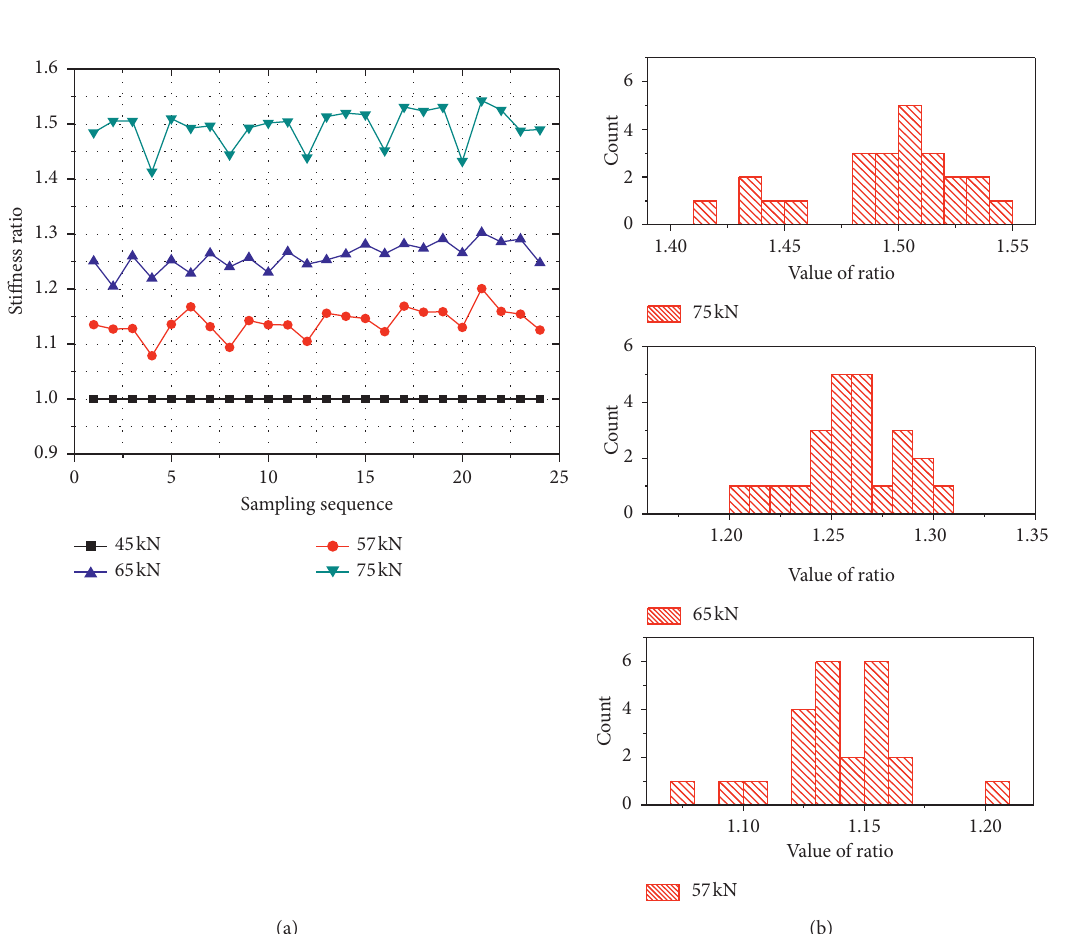
Figure 10: The curve of the stiffness ratio and interval statistics. (a) The curve of the stiffness ratio. (b) Chart of frequency